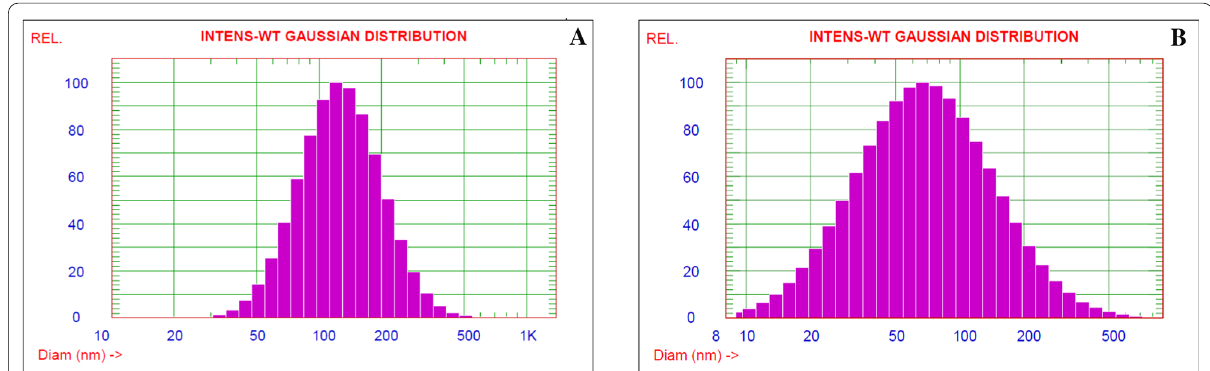
Fig. 3 Particle size of Laury essential oil nanoemulsion: A with size 139.3 nm and B with size 89.2 nm at 3 and 5% concentrations, respectively